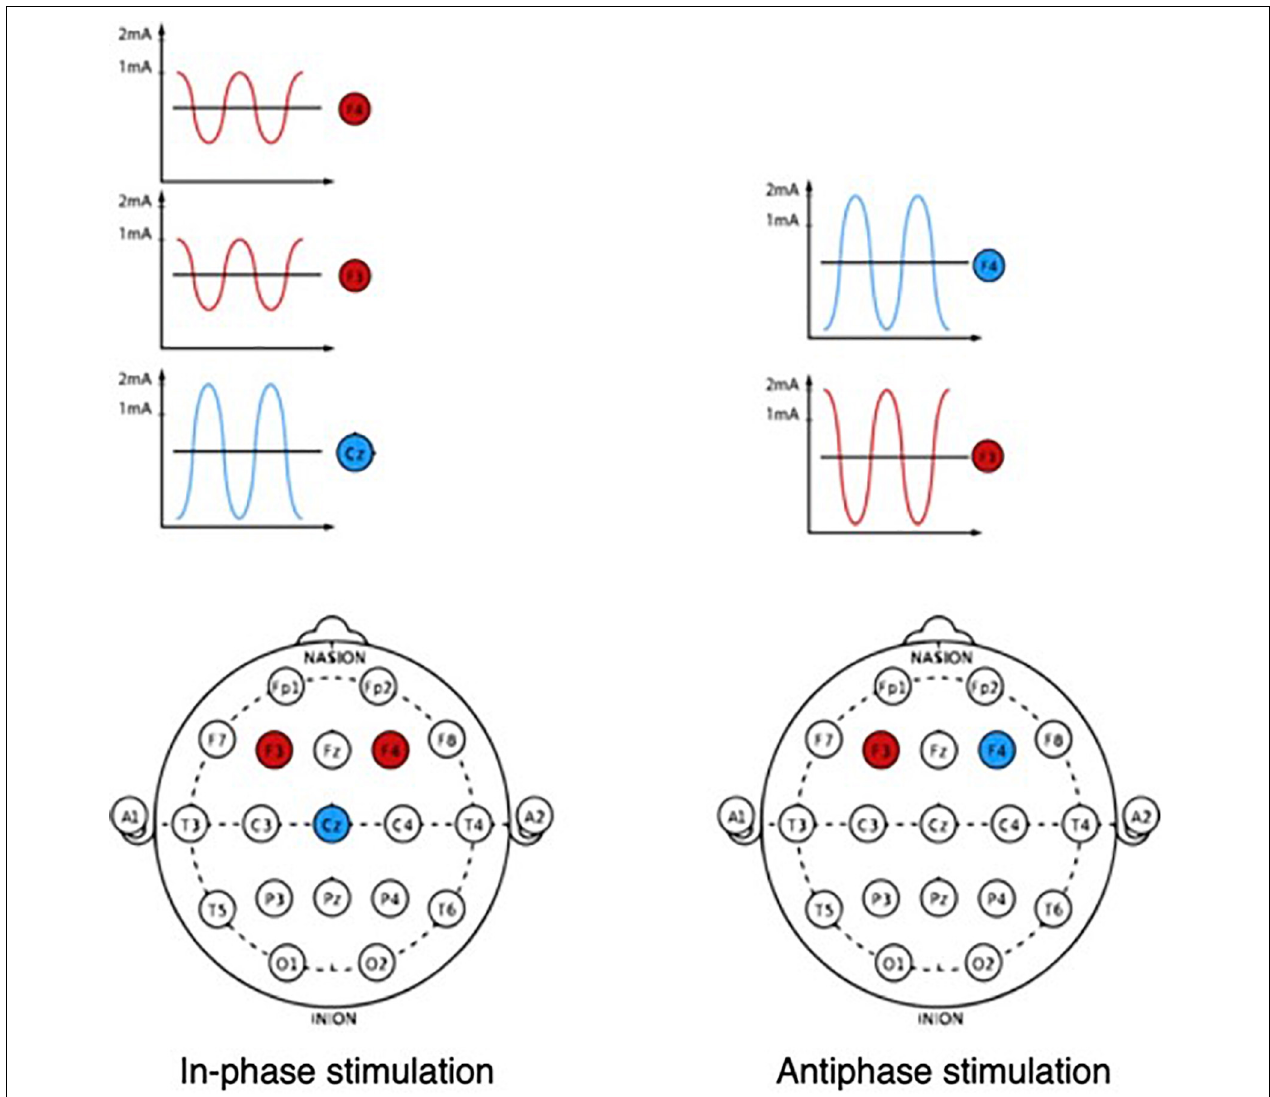
FIGURE 2 | The tDCS mechanism. Shift of membrane excitability when exposed to a weak direct